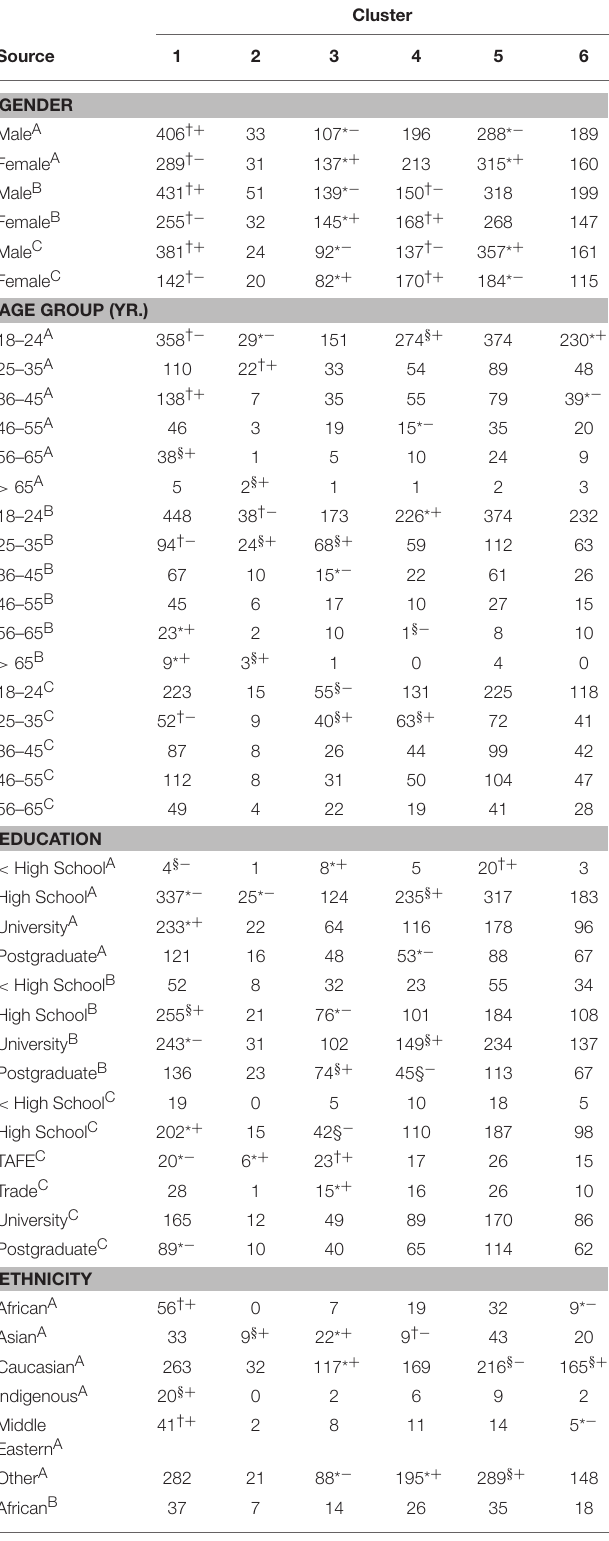
TABLE 12 | Distribution of mood profile clusters by gender, age, education, and ethnicity.